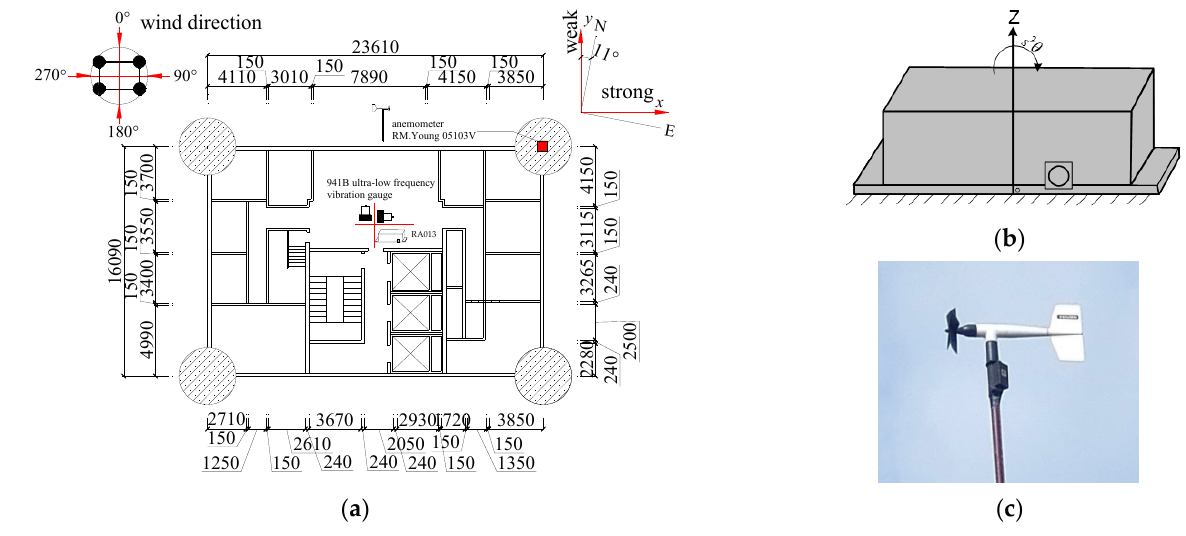
Figure 4. Plan view of the measured building and monitoring instruments. ( a ) Building plan; ( b ) RA013 rotational accelerometer; ( c ) Anemometer. Table 1. Specifications of the anemometer and acceleration sensors.